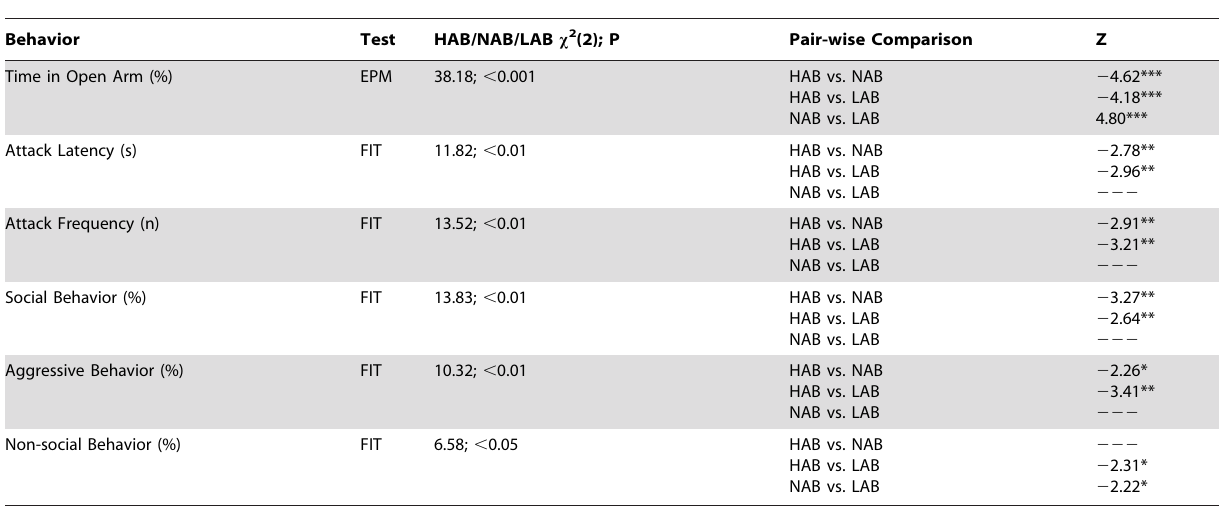
Table 2. Effect of innate anxiety levels on behavior in the FIT.